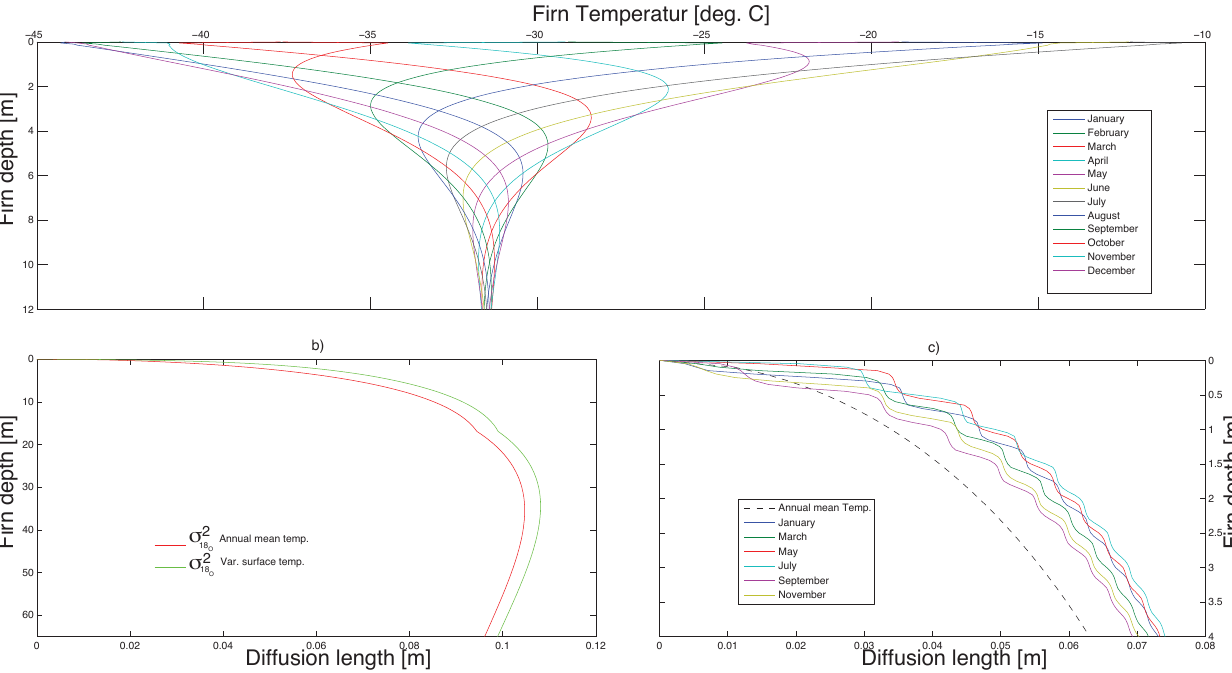
Fig. 1. Temperature profiles and diffusion lengths for the NorthGRIP firn column modelled under present day conditions. (a) The temperature field to a given month of the year. (b) The model diffusion length of δ 18 O both under constant temperature conditions and using the temperature variations seen in (a) from the surface to the pore close off. (c) The diffusion length of the top 4m for selected